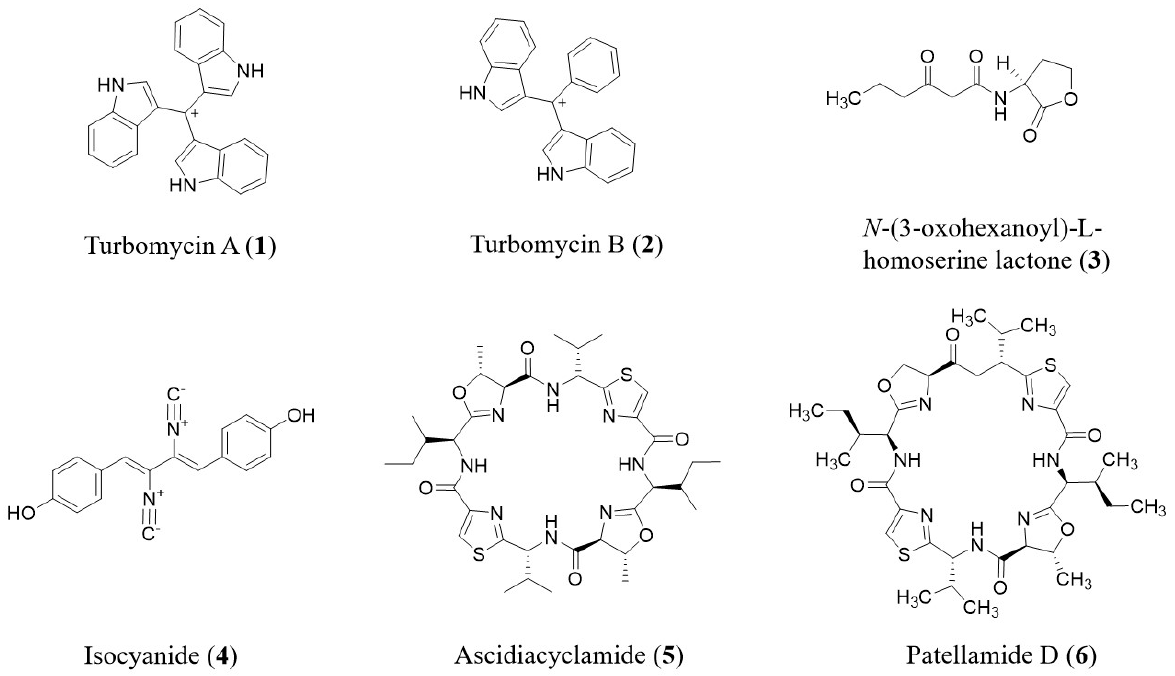
Figure 2. Natural products discovered by function ‐ based screening of metagenomic ‐ library clones.